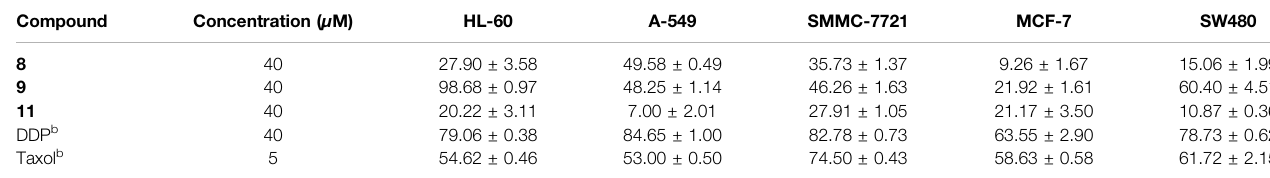
TABLE 4 | In vitro cytotoxic activity (cell inhibition (%)) of compounds 8 , 9 , and 11 against fi ve human tumor cell lines a